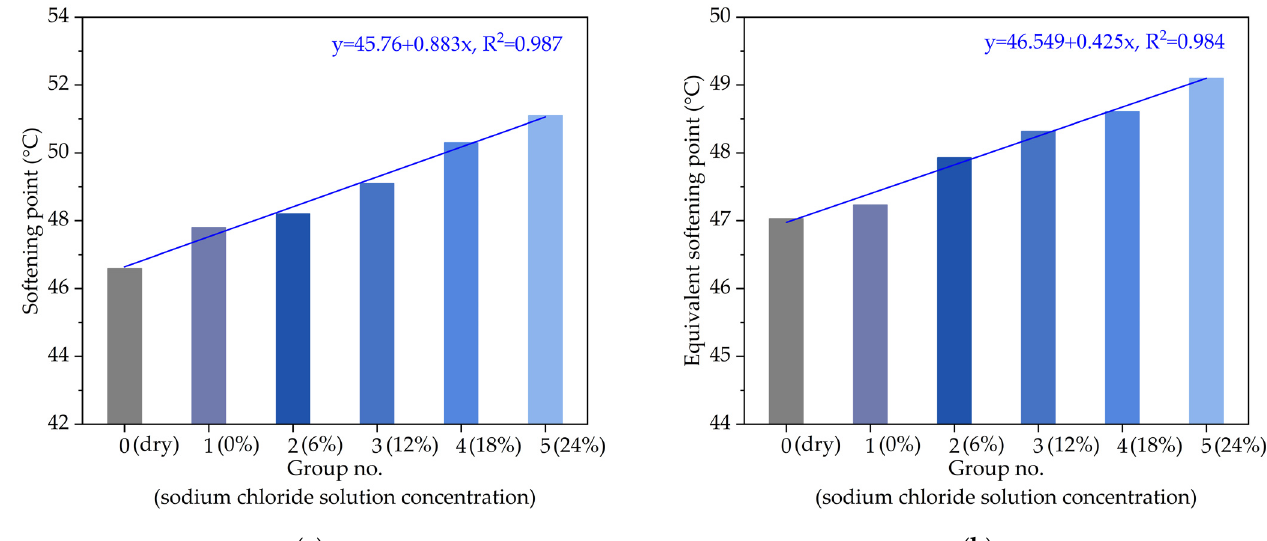
Figure 2. Snow melting ability of chloride salt solutions with concentrations.